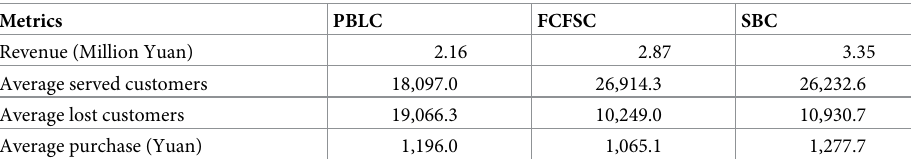
Table 7. Results of the real world